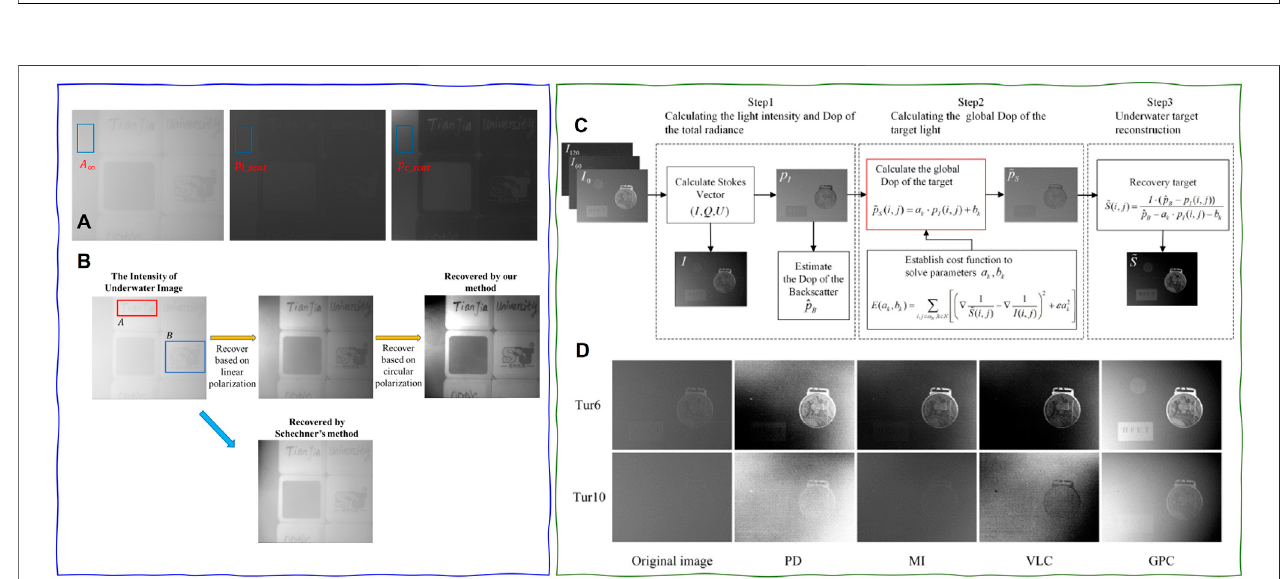
FIGURE 10 | (A) Intensity image of the scene, DoLP, and DoCP. (B) Recovery comparison for methods in [46] and [32] (reprint from OSA: Optics Express [46], copyright 2018). (C) Flowchart of underwater polarization reconstruction utilizing polarimetric calculation method of the global pixel. (D) Comparison results of three classical restoration methods (PD: polarization difference [41], ML: Schechner ’ s method [35], VLC: Vanderlugt correlator) and this method in different turbidity (reprint from IEEE: Photonics Journal [52], copyright 2021).